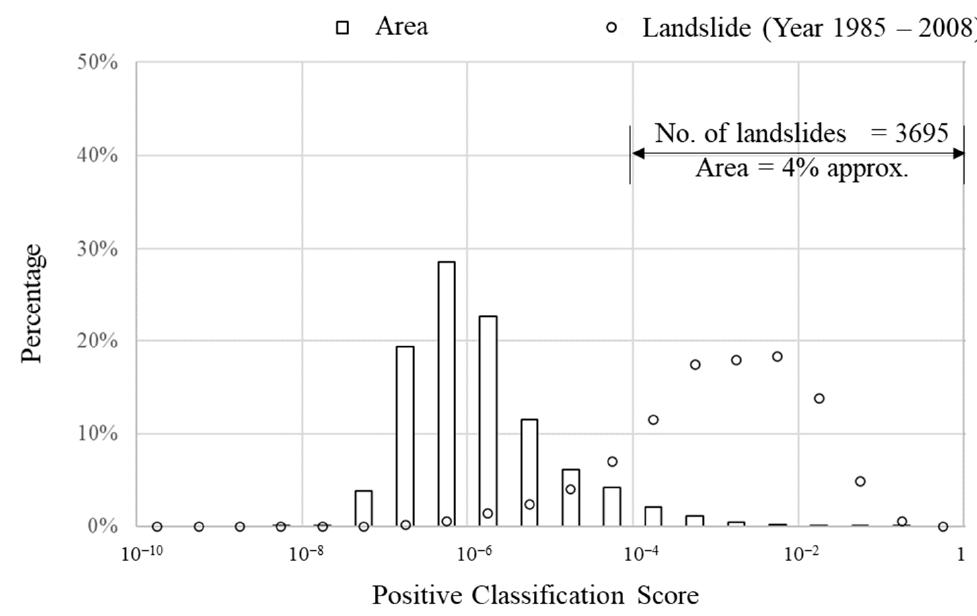
Figure 12. Distribution of Past Landslide Occurrences and Area by Positive Classification Score.